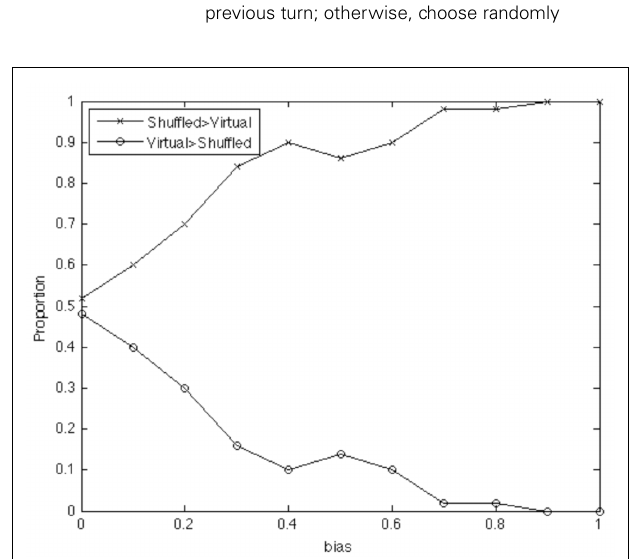
FIGUREA1 | Simple shuffling tends to produce a higher proportion of simulated baselines than the virtual pair method, especially as the ‘true’ coupling between systems